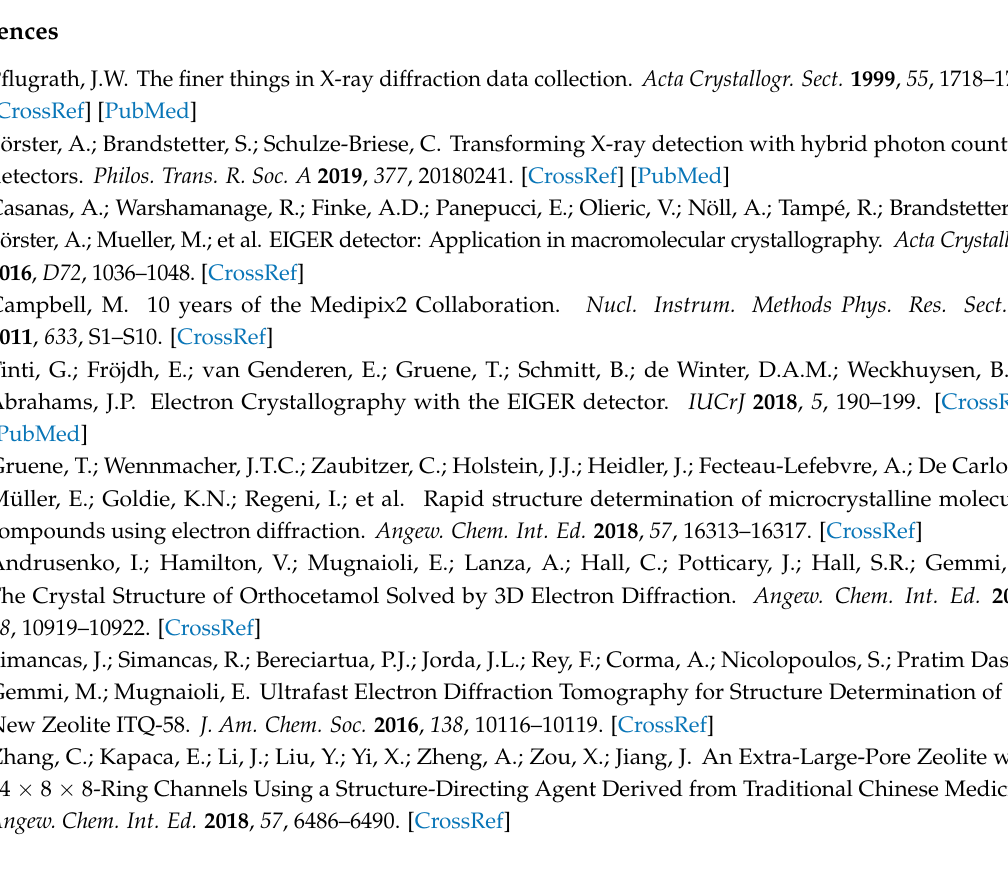
s1, Figure S1: Data for albite structure depending on the T1–T4 compositions, Figure S2: S1 Cont’d: Data for albite structure depending on the T1–T4 compositions, Figure S3: S1 Cont’d: Data for albite structure depending on the T1–T4 compositions, Figure S5: Data for Zeolite A structure depending on the T1/T2 composition, Table S1: T-O bond lengths for the refined structure of albite, Table S2: T-O bond lengths for the refined structure of zeolite A, crystal 3, Table S3: Information for data sets from 9 crystals merged for albite, Table S4: Data statistics for albite after merging of data sets from 9